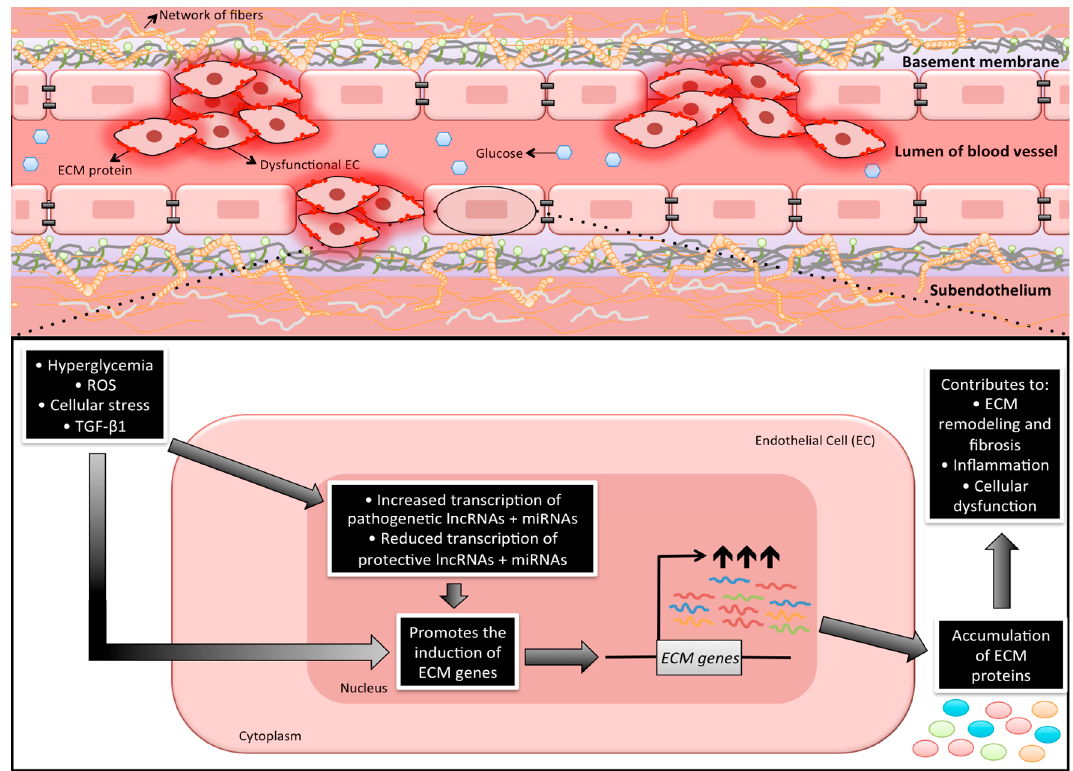
Figure 1. An illustration depicting the potential involvement of long non-coding RNAs (lncRNAs) and microRNAs (miRNAs) in the regulation of extracellular matrix proteins in endothelial cells during diabetes. As endothelial cells (ECs) are the first cell types to be exposed to systemic hyperglycemia, increased intracellular glucose triggers a number of metabolic disturbances. Among these disturbances, chronic hyperglycemia can cause the endothelium to lose its inherent physiological properties. Because these changes work primarily through the transcriptional machinery of the cell, recent research is beginning to demonstrate that non-coding RNAs are implicated in this complex pathogenetic process. In fact, the aberrant production of extracellular matrix (ECM) proteins in diabetes has been linked to many miRNAs and lncRNAs, which suggests that these non-coding RNAs are key epigenetic regulators in such a synthetic process. Additional notes: Cells denoted as “dysfunctional EC” in the image above are showcasing the abnormal ECs that have heightened production and deposition of ECM proteins. As well, the endothelial basement membrane is comprised of a complex network of fibers (includes collagen IV and laminin) that crosslink with many other proteins (i.e., perlecans). Endothelial cells are connected to this network by the presence of integrins (the orange molecules in the diagram). Of note, it has been documented that early hyperglycemia can provoke basement membrane thickening, which can have many detrimental consequences, such as the inability to prevent vascular permeability [178].